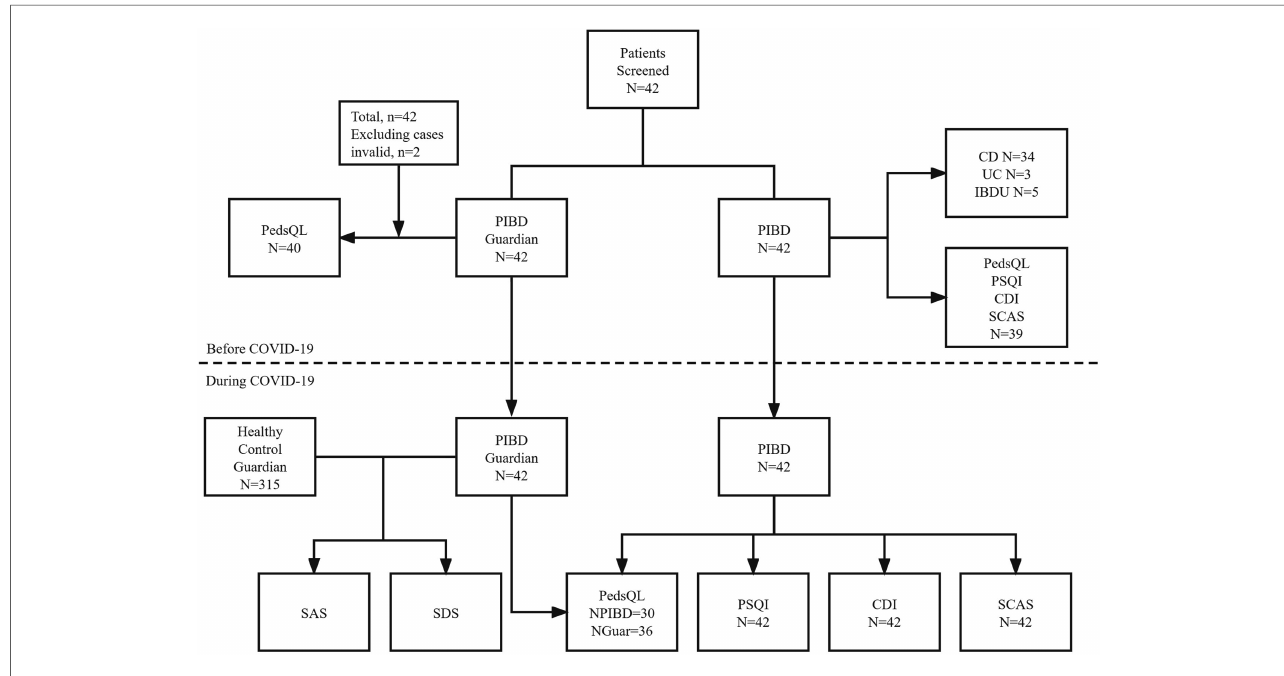
FIGURE 1 Disposition and fl ow of subjects in different